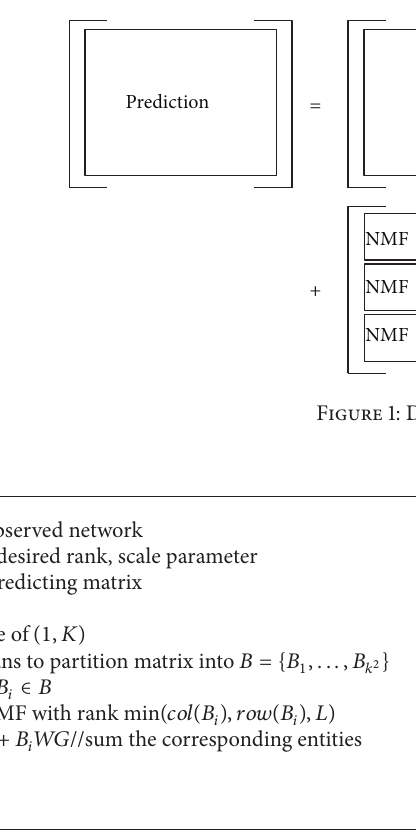
Algorithm 1: Algorithm for 𝐾 -CNMF.